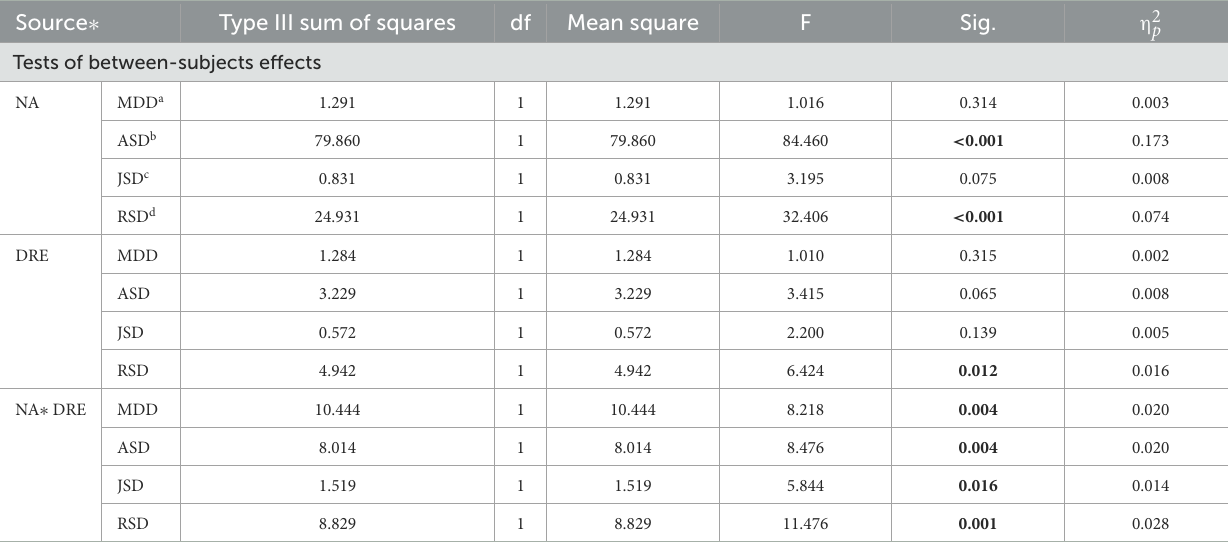
TABLE 3 Differences in moral disengagement in doping and athlete mindfulness by the NA and